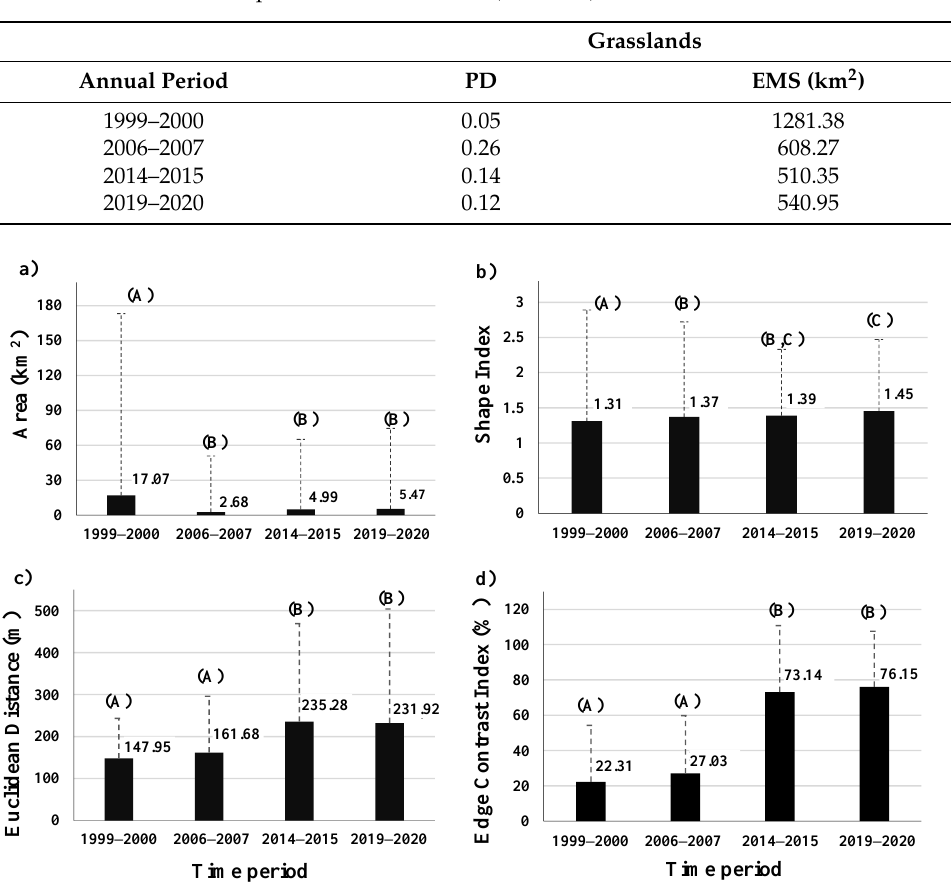
Table 4. Grassland landscape metrics at class level (PD, EMS).